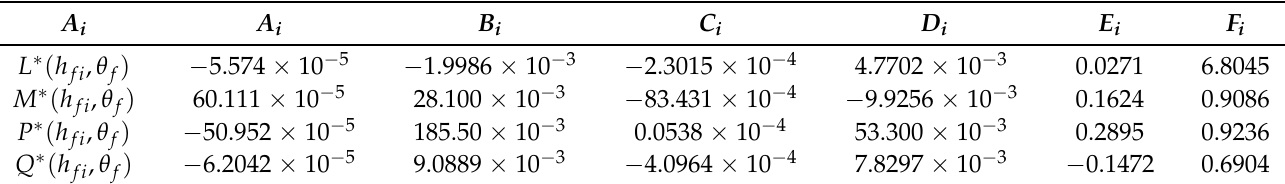
Figure A1. Nonuniform cantilever beam gear model. Table A1. Values of the coefficients of Equation